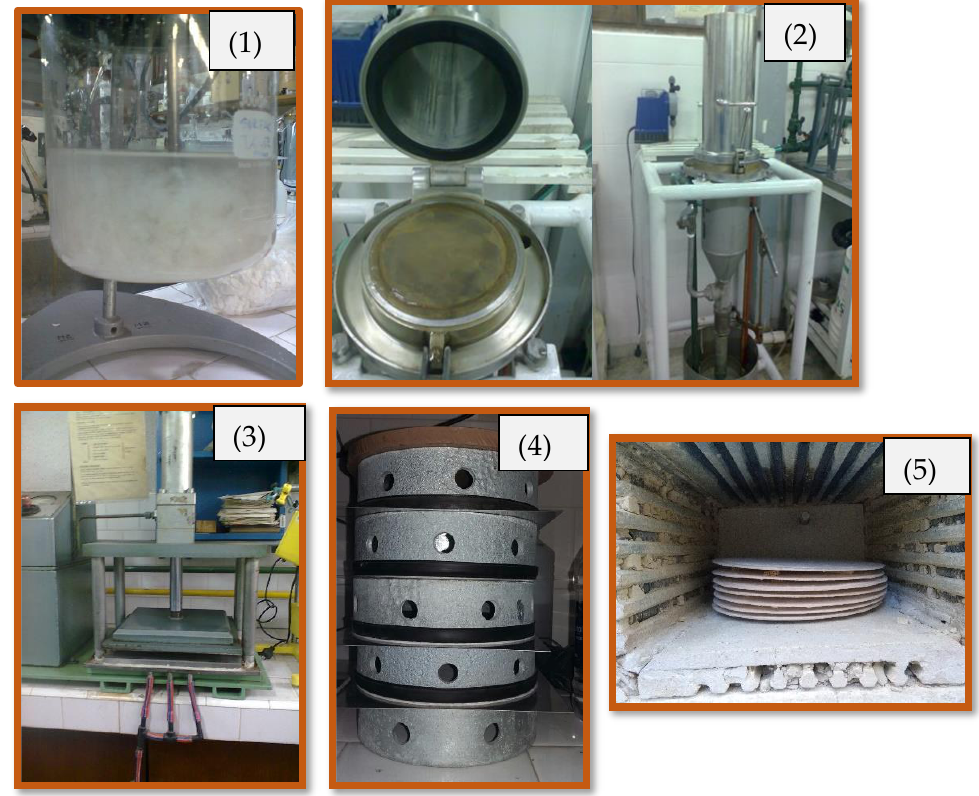
Figure 12. Images of the equipment used in each stage of the production of ceramic papers. (1) suspension of the components of the ceramic paper forming flocs by the action of polyelectrolytes, (2) paper making machine (100 µm filter mesh), (3) hydraulic press, (4) drying in a controlled environment (52% humidity, 22 °C), and (5) calcination in a muffle.